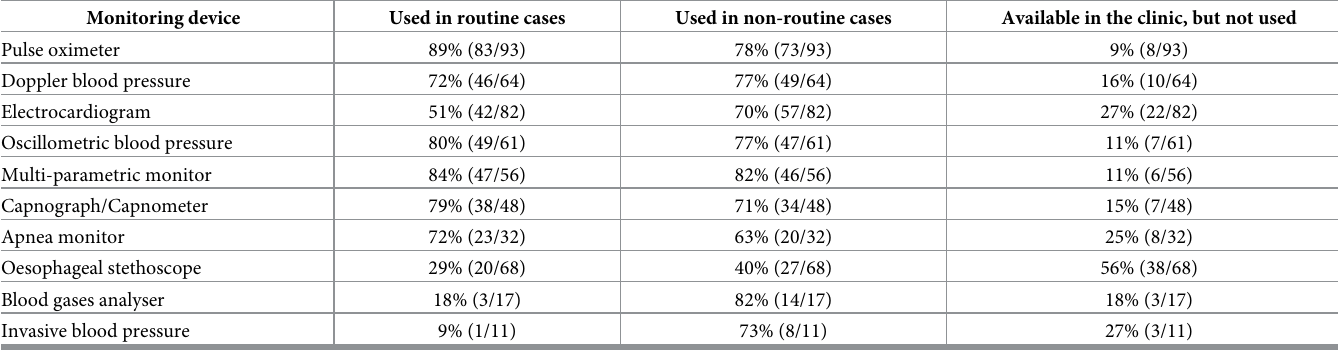
Table 8. Use of monitoring devices by English-speaking Canadian veterinarians having access to mentioned monitoring device. Monitoring